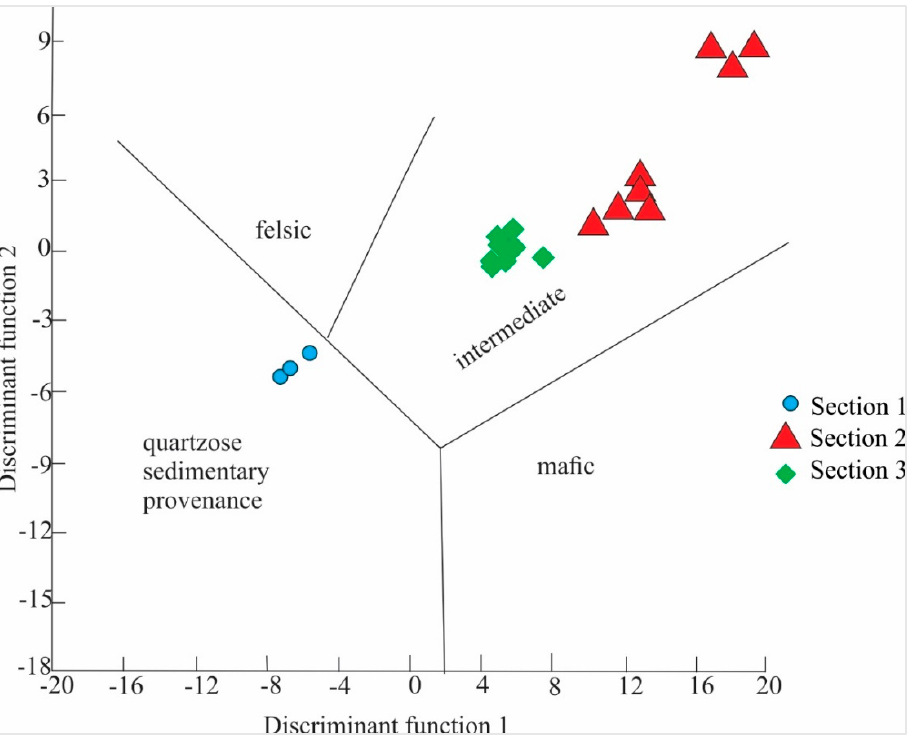
Figure 9. Provenance discrimination diagram for shales. Discriminant function 1 = ( − 1.773 × TiO 2 %) + (0.607 × Al 2 O 3 %) + (0.76 × Fe 2 O 3 T%) + ( − 1.5 × MgO%) + (0.616 × CaO%) + (0.509 × Na 2 O%) + ( − 1.22 × K 2 O%) + ( − 9.09). Discriminant function 2 = (0.445 × TiO 2 %) + (0.07 × Al 2 O 3 %) + ( − 0.25 × Fe 2 O 3 T%) + ( − 1.142 × MgO%) + (0.438 × CaO%) + (0.432 × Na 2 O%) + (1.426 × K 2 O%) + ( −